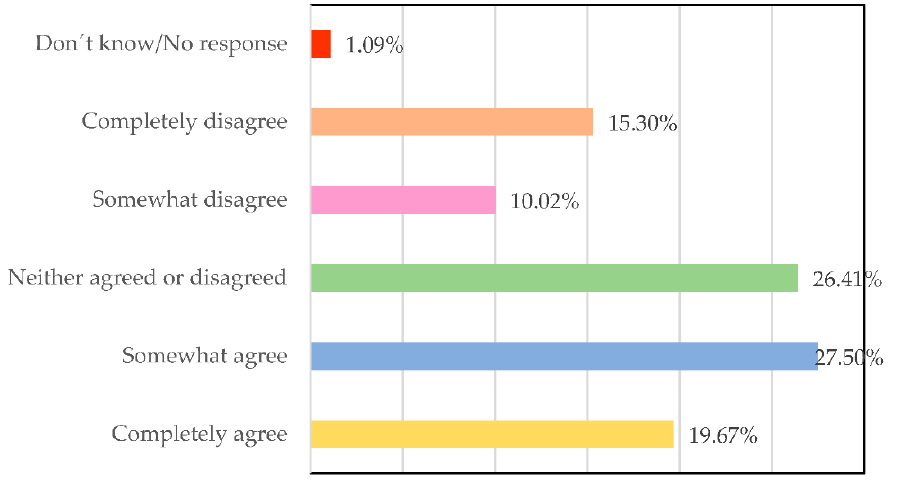
Figure 2. Women and men lead differently. Source: Own elaboration.